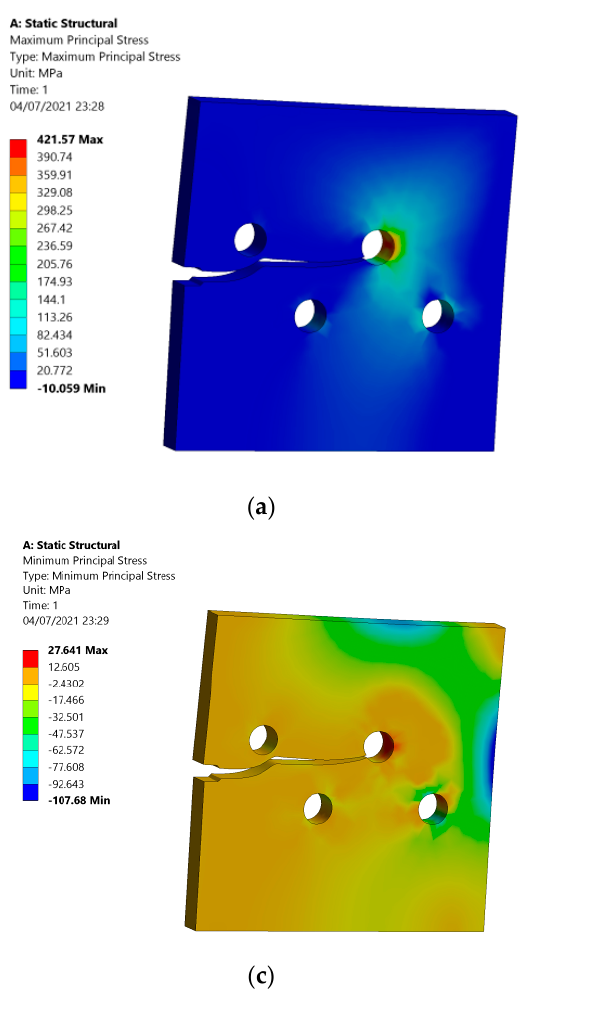
Figure 6. Crack growth trajectory: ( a ) maximum principal stress (10 mm thickness), ( b ) maximum principal stress (20 mm thickness), ( c ) minimum principal stress (10 mm thickness), ( d ) minimum principal stress (20 mm thickness).